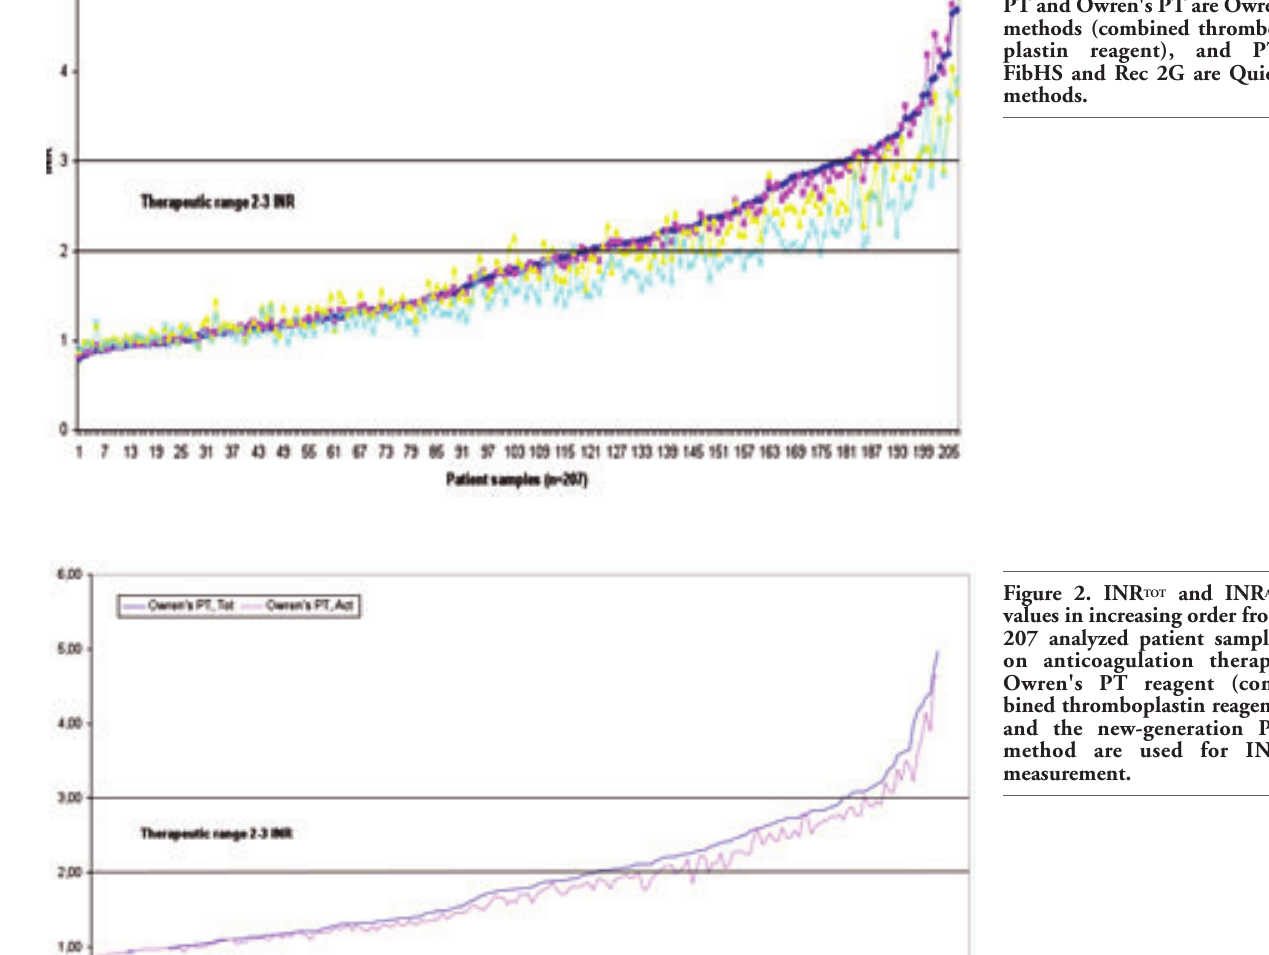
Figure 3. Rec 2G, Quick PT, INR, and Owren's PT (com- bined thromboplastin reagent) INRACT values in increasing order from 207 analyzed patient samples on anticoagu- lation therapy. The new-gener- ation PT method is used for INRACT